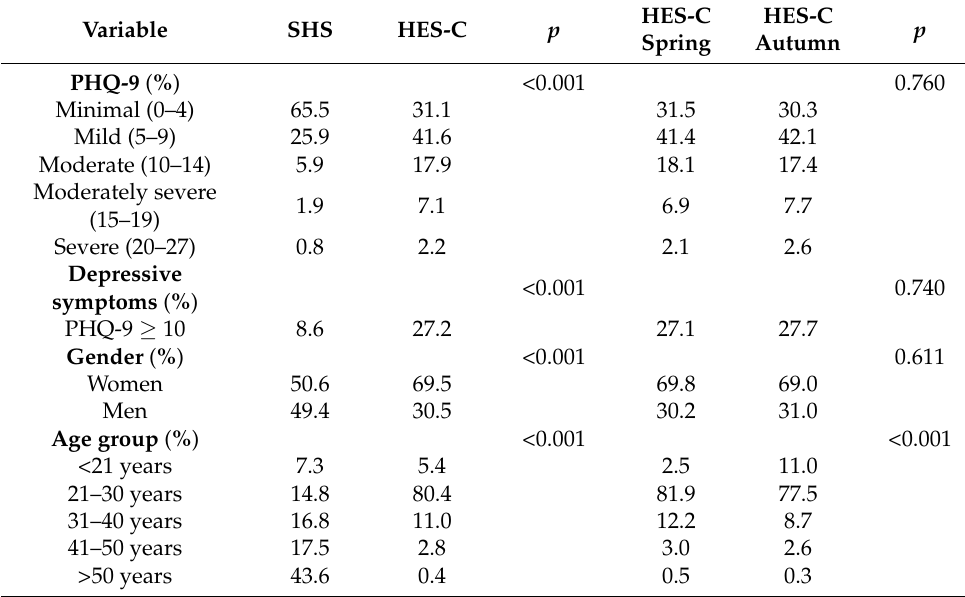
HES-C HES-C Spring